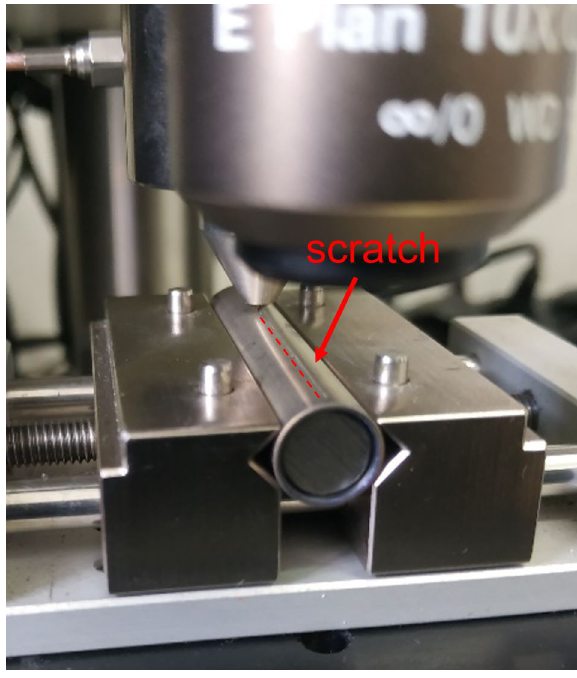
Figure 4. Scratch Test Revetest Xpress.